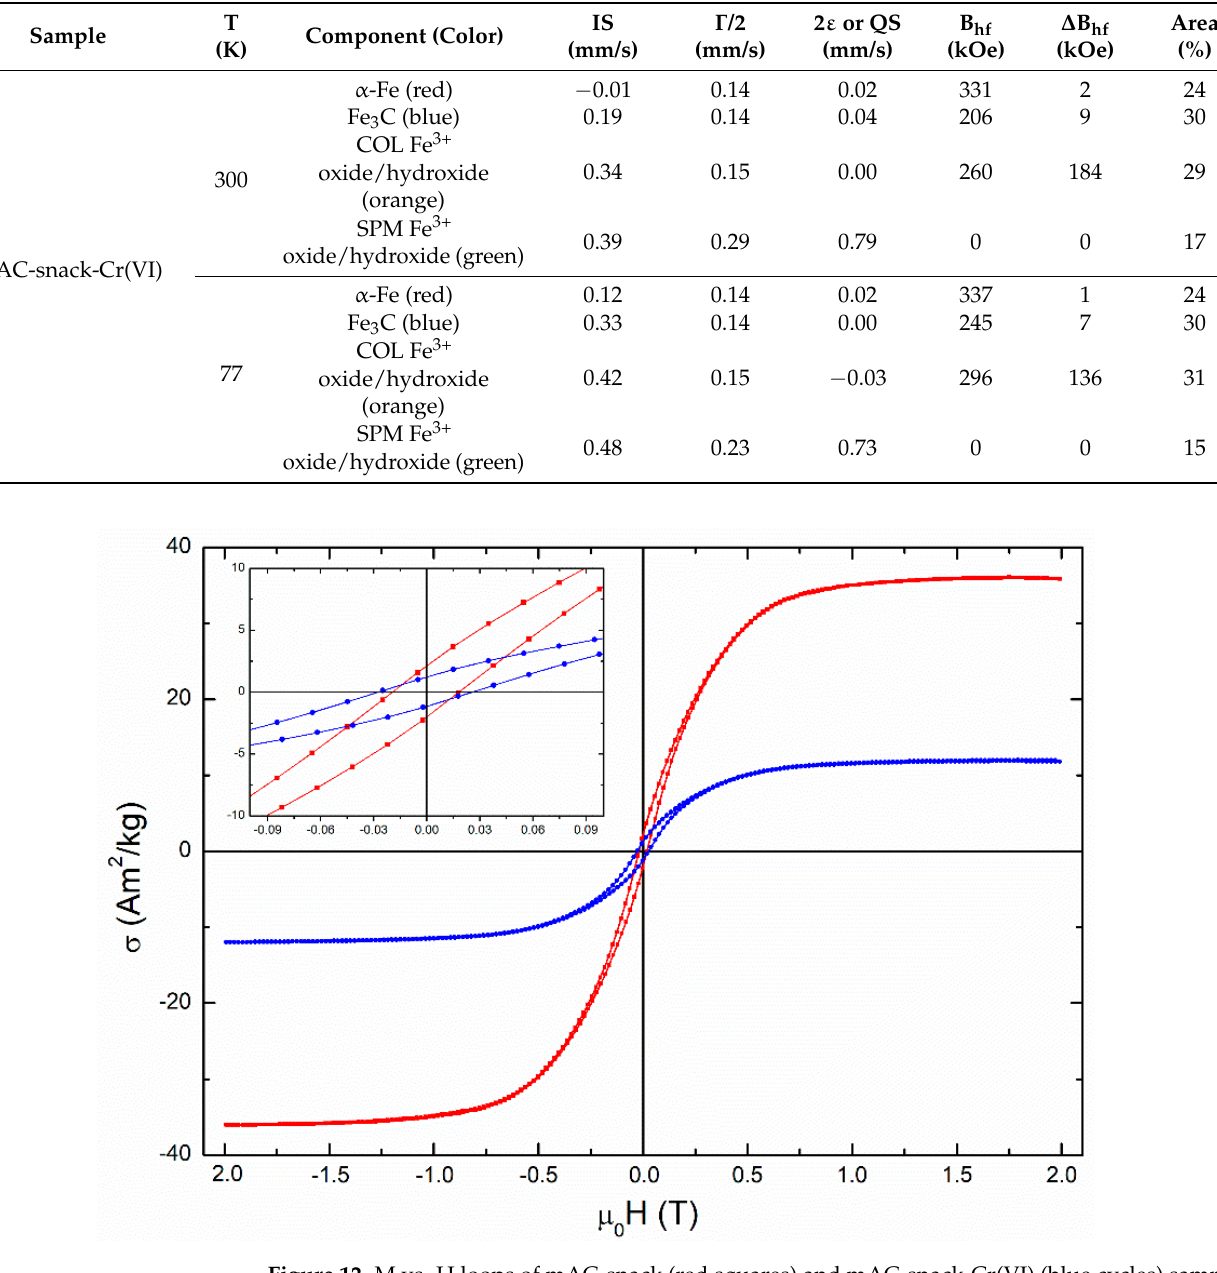
Figure 12. M vs. H loops of mAC-snack (red squares) and mAC-snack-Cr(VI) (blue cycles) samples recorded at room temperature. The inset presents a magnification focused on the loops’ center to reveal their coercive